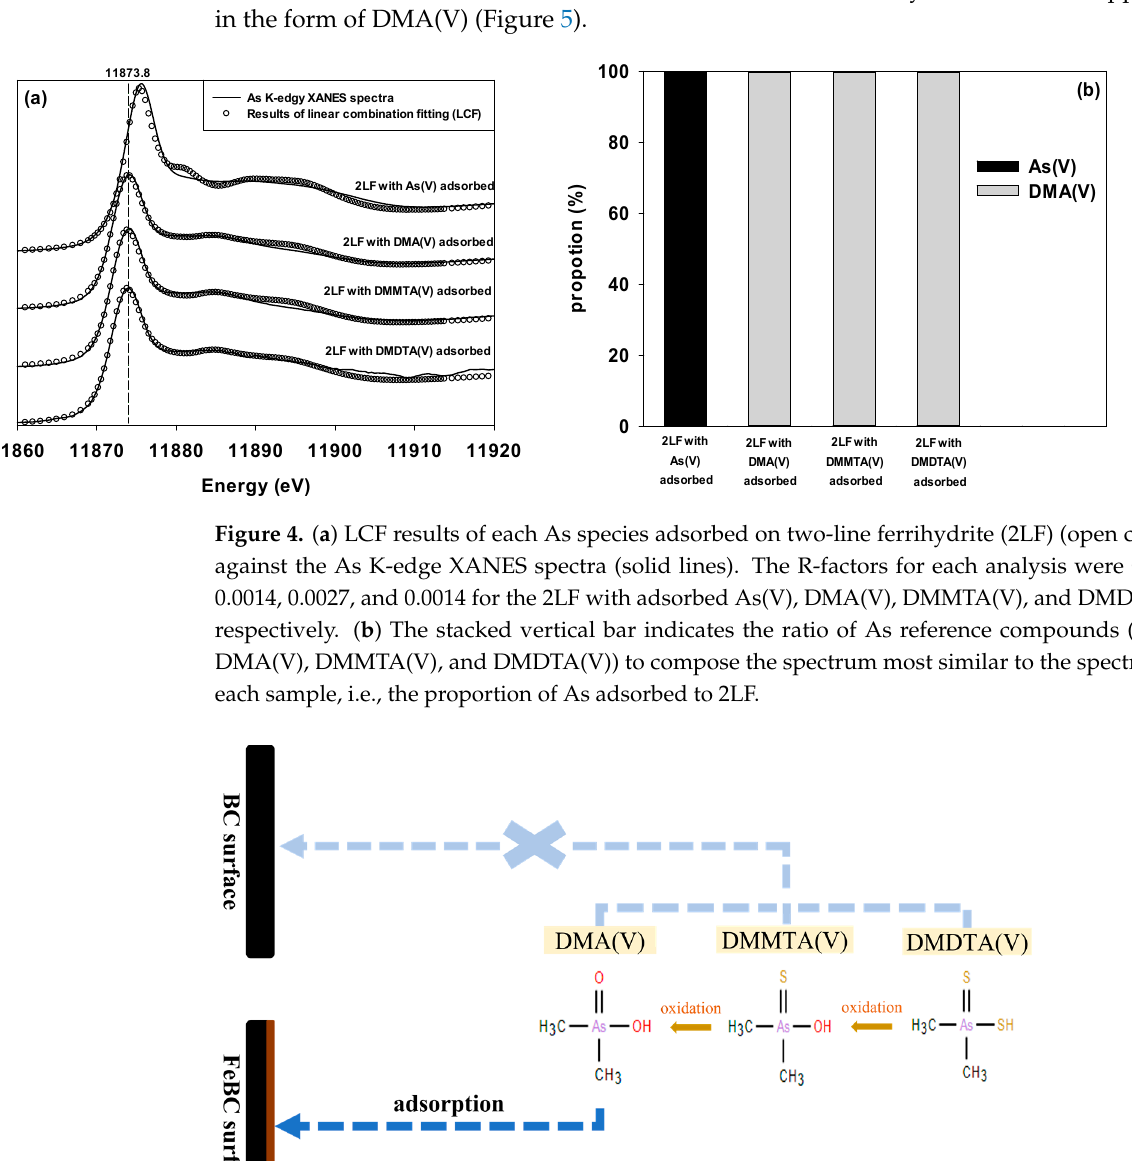
Figure 5. Proposed adsorption mechanisms of dimethylated arsenicals on FeBC.